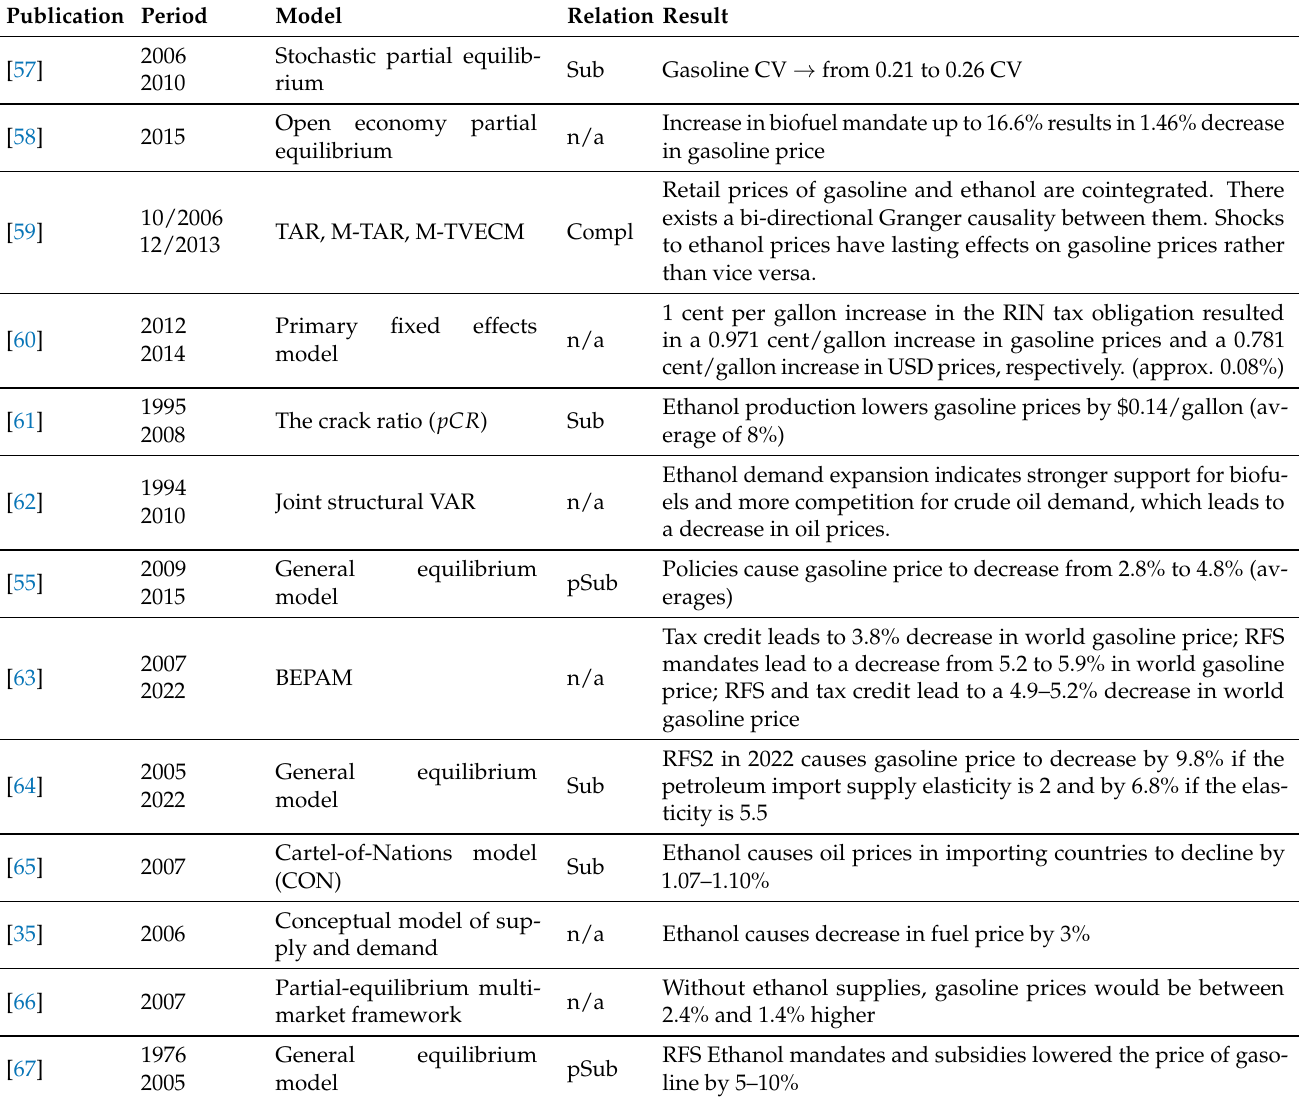
Table 1. This table summarizes publications providing numerical estimates of the impact of ethanol on fuel price. The first column references the publication and the second column the inspected time period. The third column reports on the model used, and the Relation column suggests whether ethanol and gasoline are considered to be substitutes (Sub), complements (Comp), or perfect substitutes